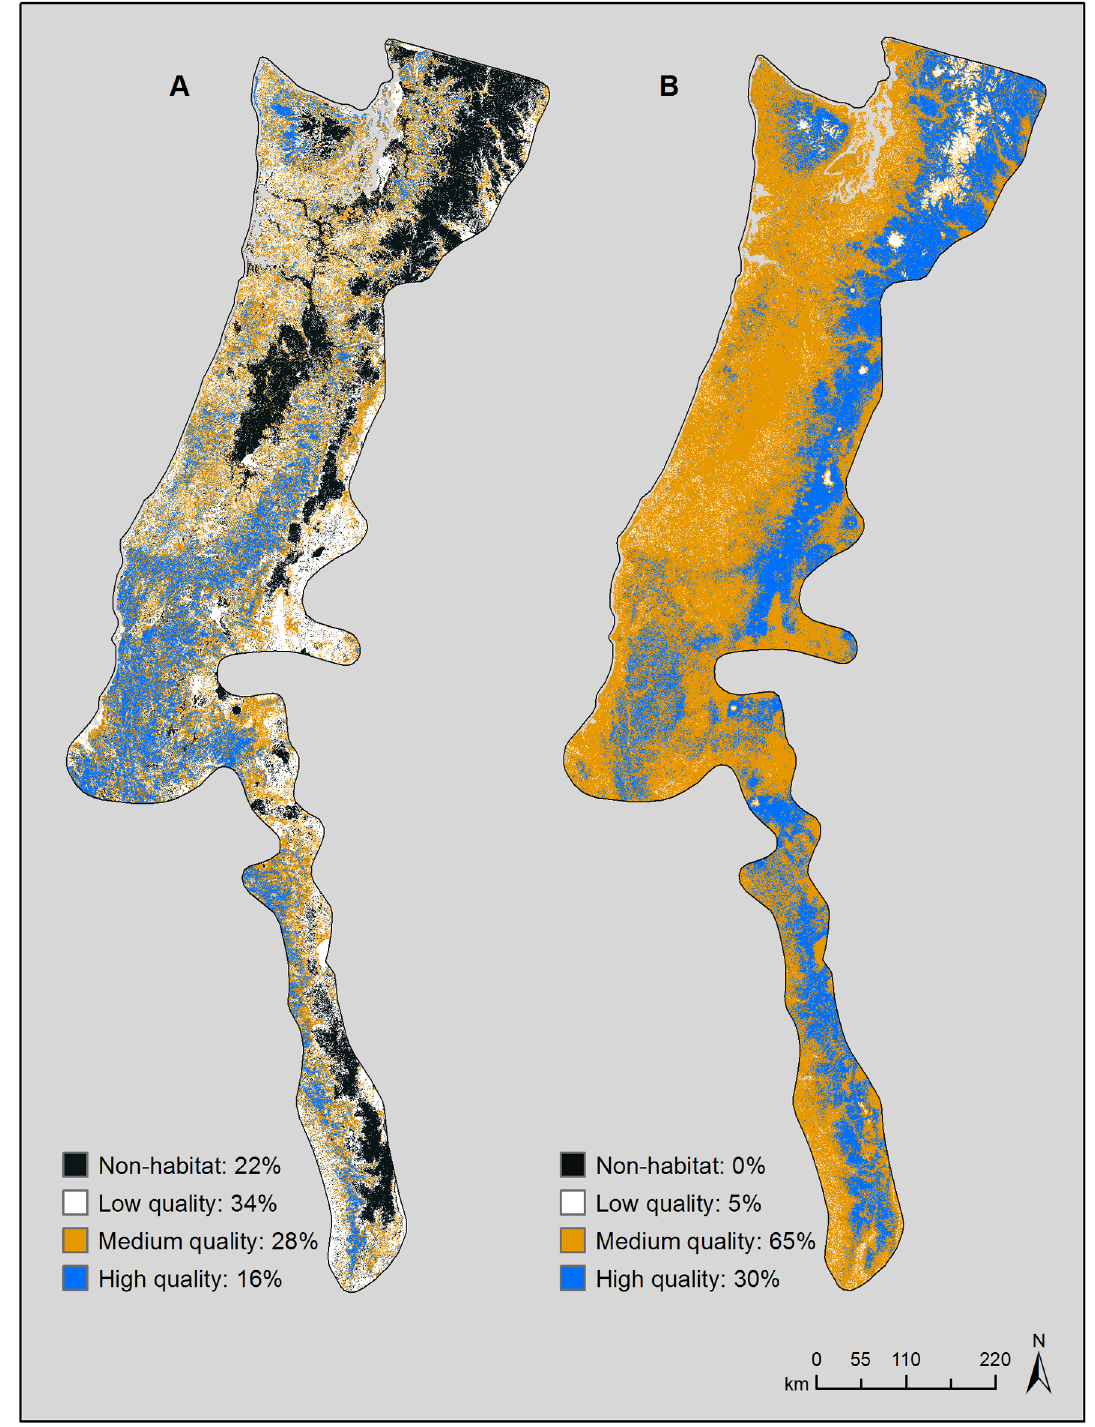
Fig 4. Species distribution maps for the fisher in the Pacific States created using logistic values (relative habitat- quality indices) generated in Maxent based on (A) the final verifiable fisher model, and (B) the final unscreened fisher